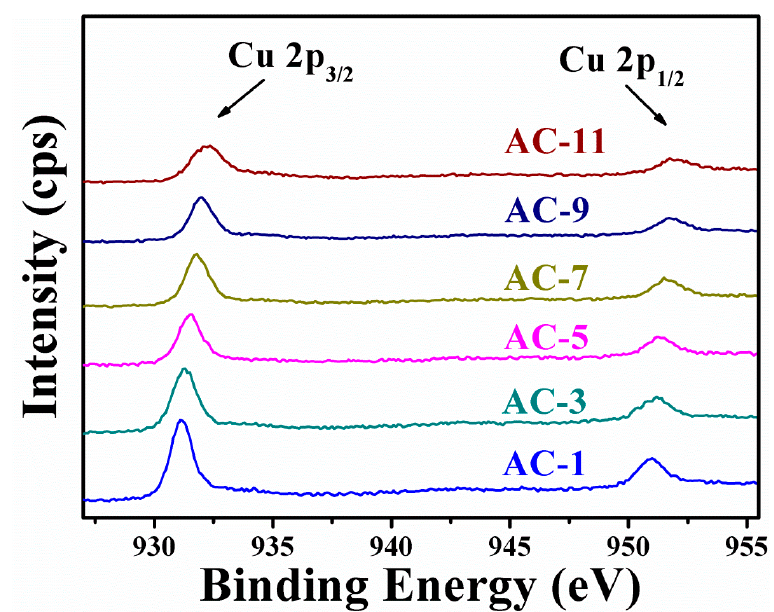
Figure 5. High resolution XPS scans of Cu 2p for AC-1 NCs, AC-3 NCs, AC-5 NCs, AC-7 NCs, AC-9 NCs, and AC-11 NCs.